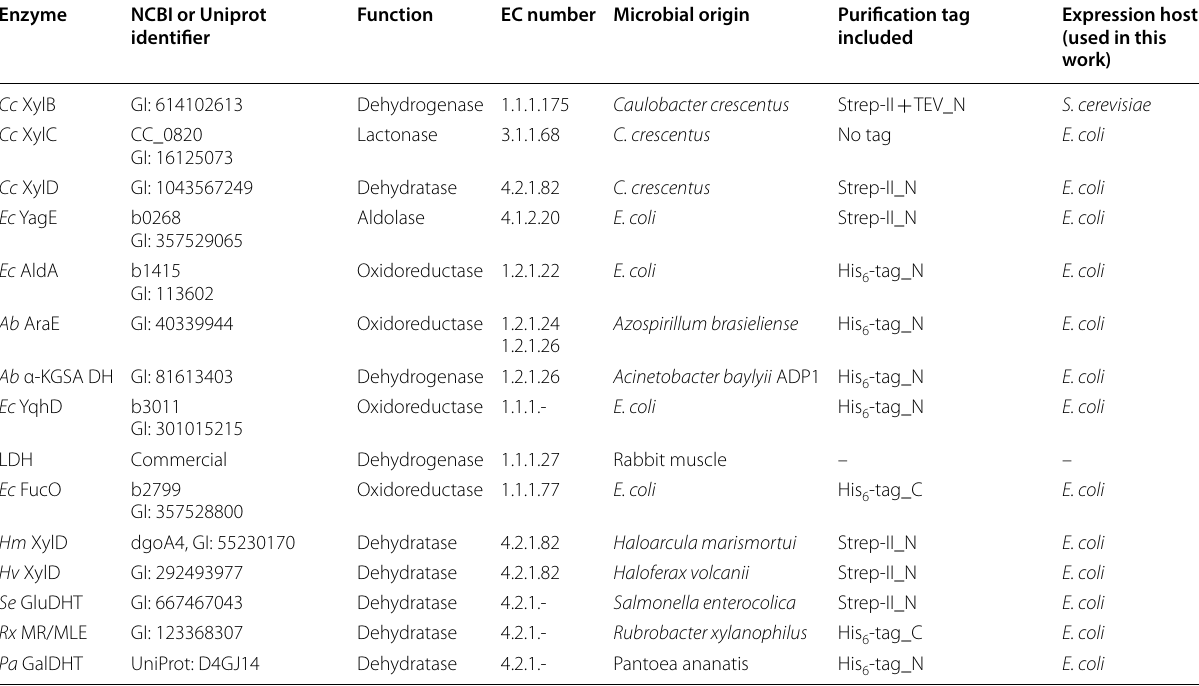
The NCBI/Uniprot identifier, function, EC number, microbial origin, purification tag and expression host are specified